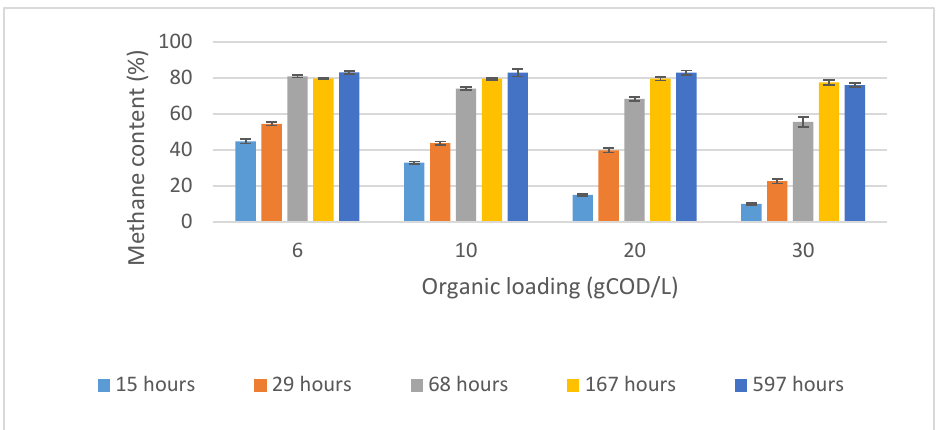
Figure 5. Methane content of H170 at different OLs over time in syringes.